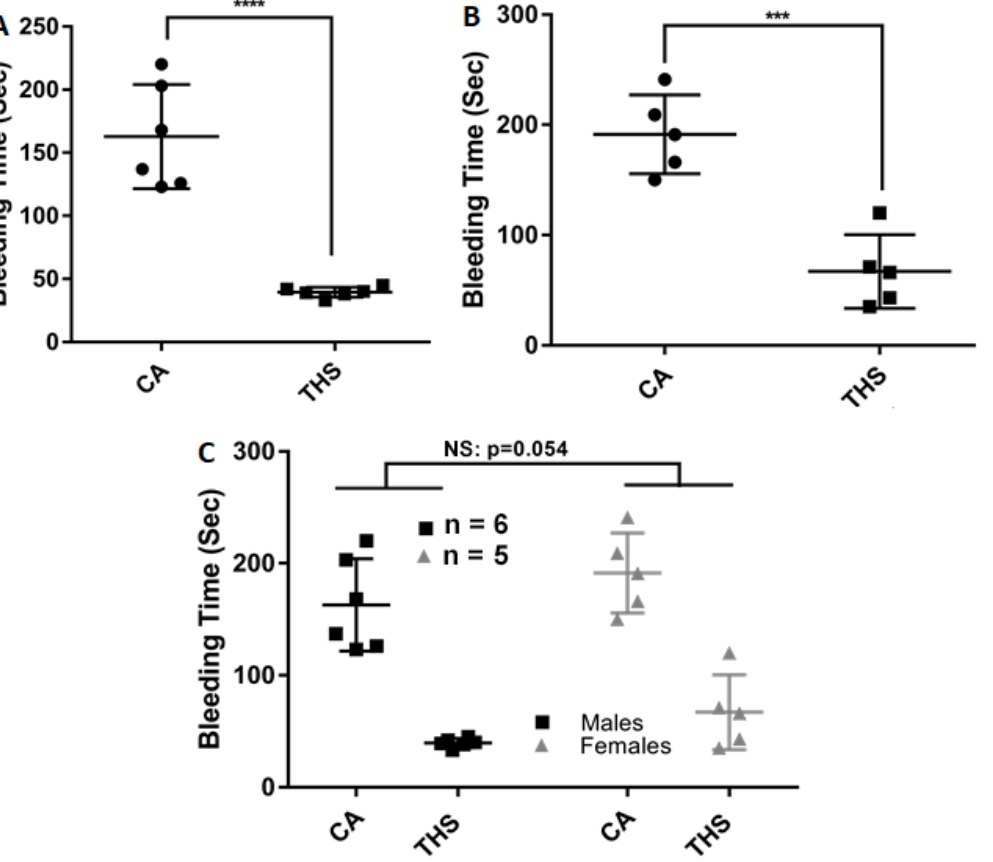
Figure 4. THS-exposed mice showed decreased tail bleeding times. THS-exposed and CA-exposed ( A ) male and ( B ) female mice were anesthetized with isoflurane and a 5 mm segment from their tails was transected and the tail bleeding assay was performed as described in the methods section. Intersex differences are shown in panel ( C ). Each point represents the bleeding time of a single ani- mal (*** p < 0.001; **** p < 0.0001; NS: none significant).